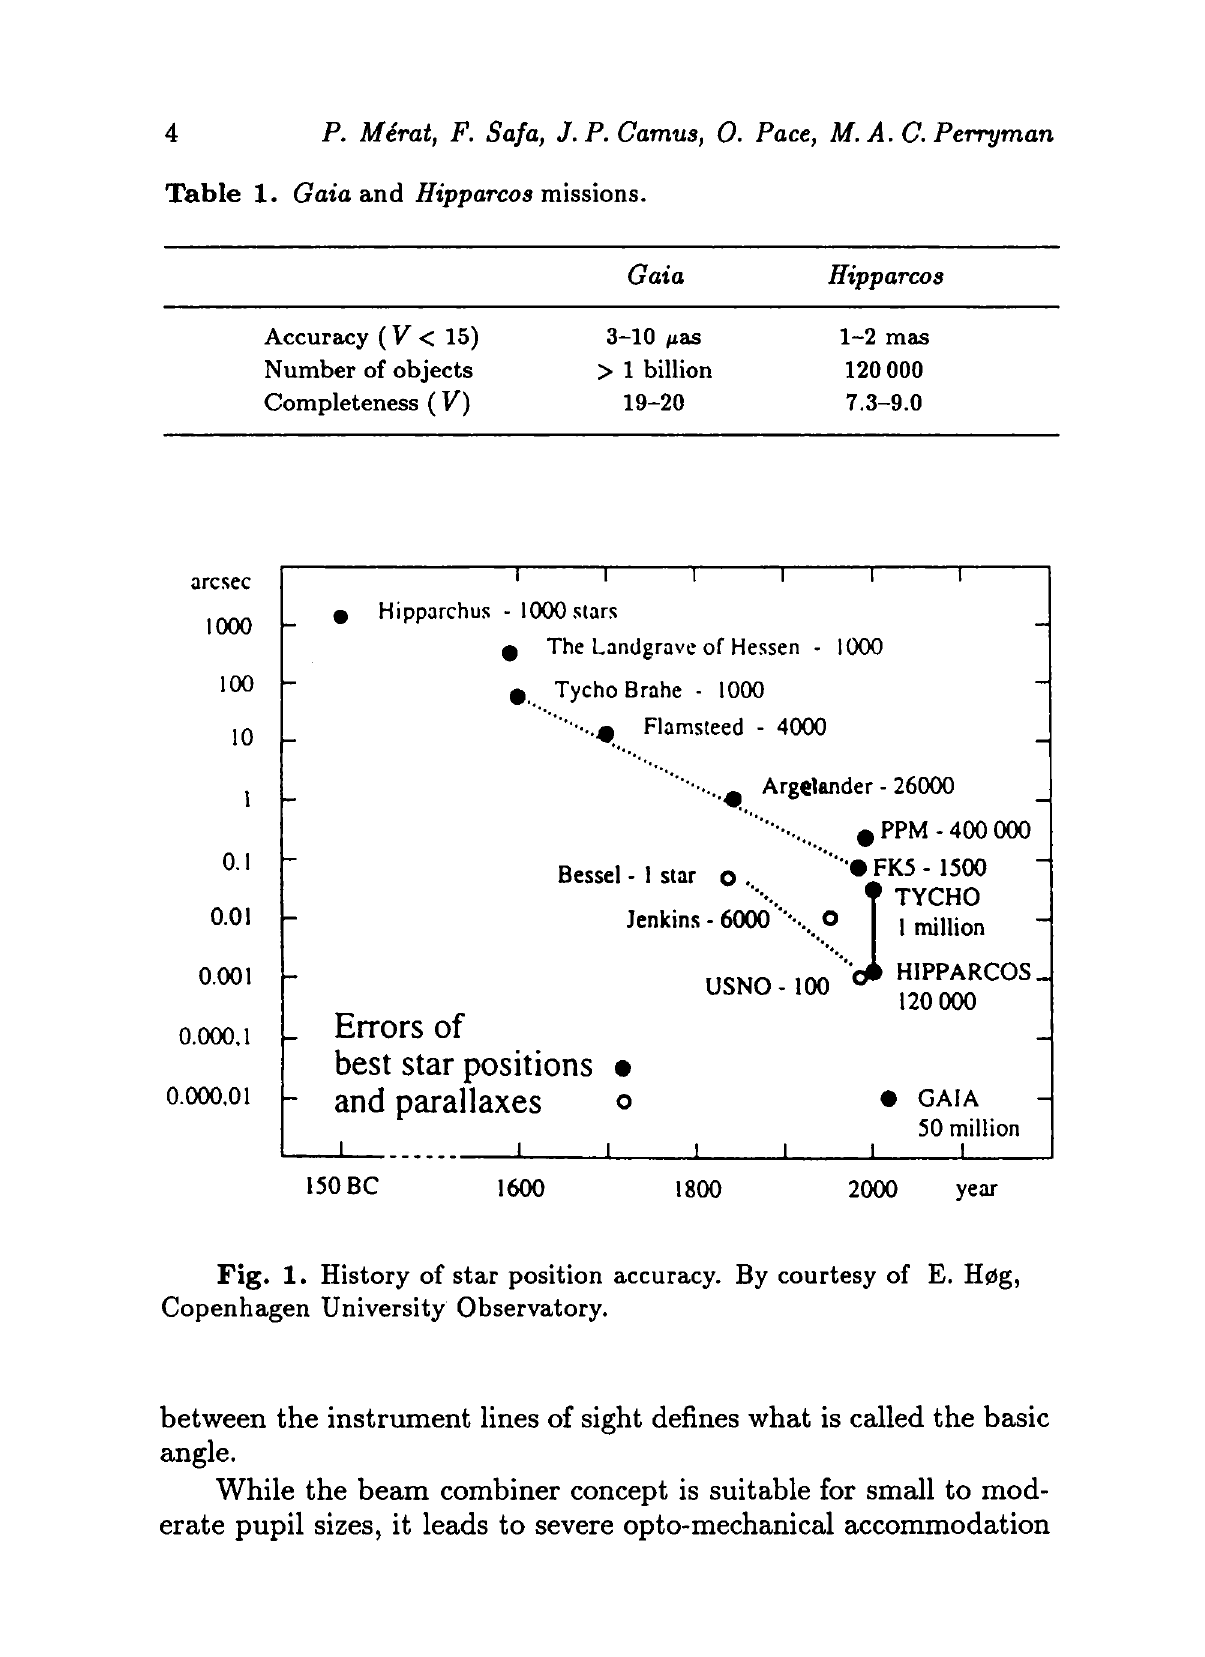
Table 1. ΰαία and Hipparcos missions.